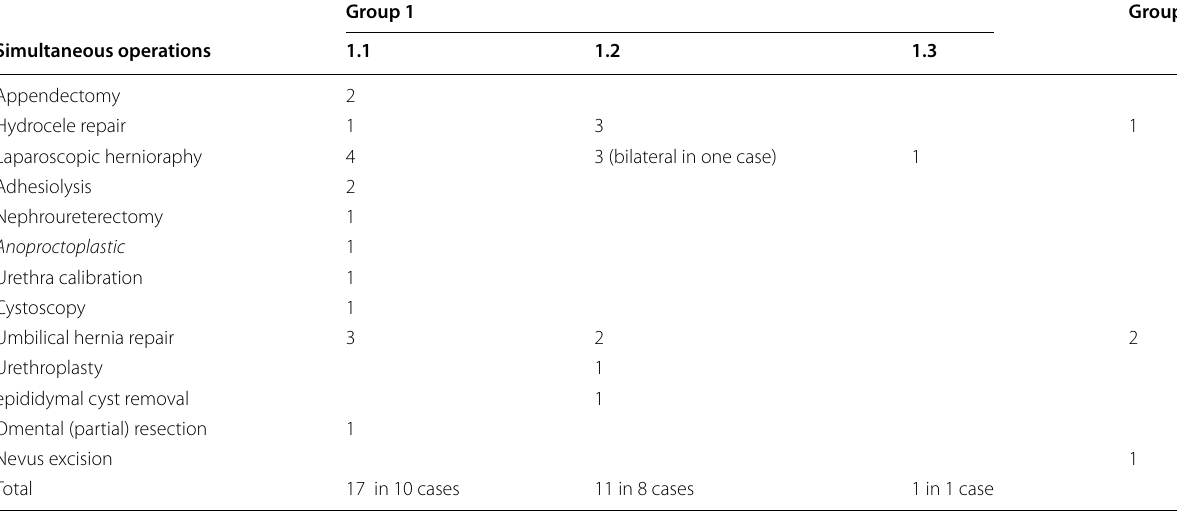
Table 4 The different associated operations performed in patients affected by urachal